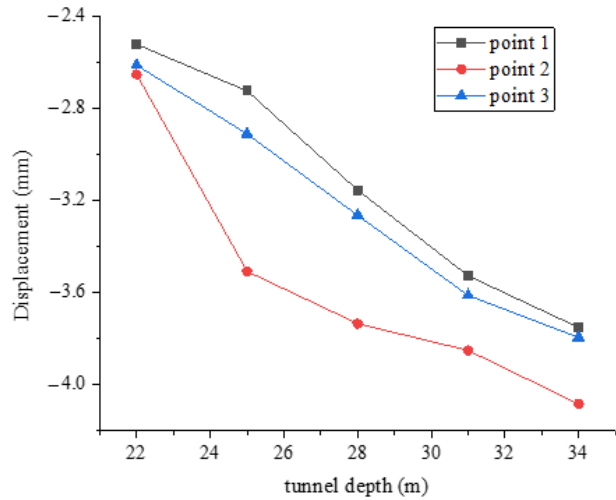
Figure 12. Variation curve of displacement at different monitoring points with the tunnel depth.